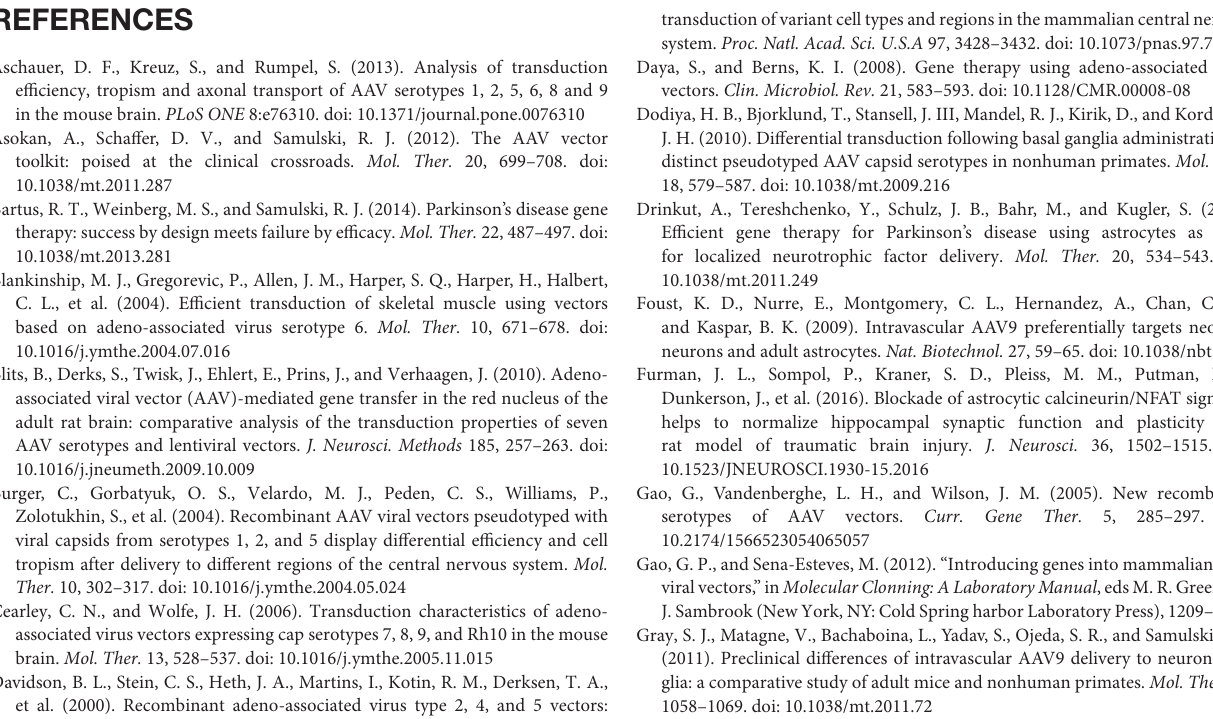
FIGURE S2 | Propagation of viral transduction in the brains infected with rAAV2 or rAAV6. Immunohistochemical images of the coronal sections from a representative animal injected with rAAV2 ( left column) or an animal injected with rAAV6 ( Right column). The 25- µ m coronal sections were stained with anti-GFP antibody and counterstained with DAPI. Low magnification fluorescence images were captured using a Zeiss Axio Imager.M2 microscope at 50 × magnification; and multiple fields from the same section were stitched together using NeuroLucida software. The anatomical hallmarks in each section are represented by drawings prepared based on the atlas by G. Paxinos and C. Watson. “The Rat Brain” (sixth edition). INSETS show matching high magnification images from the same sections, in which GFP fluorescence was captured with a Zeiss LSM510 META confocal microscope at 250 × magnification (Scale bars = 50 µ m). An approximate position of each inset image on coronal sections is indicated by green arrows. FIGURE S3 | Representative images of the AAV2- (Left) and AAV6- (Right) injected rat brains captured at low magnification. 25- µ m brain sections were stained with the anti-GFP antibody to visualize viral transduction. Lower panels show digitally magnified fields from the selected areas. Red arrowheads point to representative neuronal-like cells. Yellow arrows point to cells with astrocytic morphology. Images were taken close to the injection site at identical 100 × magnification and exposure settings using an Olympus IX71 inverted